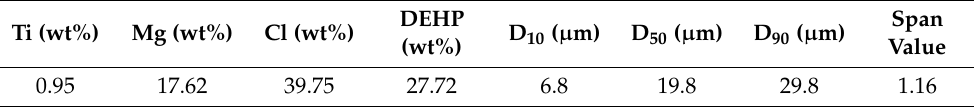
Table 1. Element and particle size analysis of the catalyst.